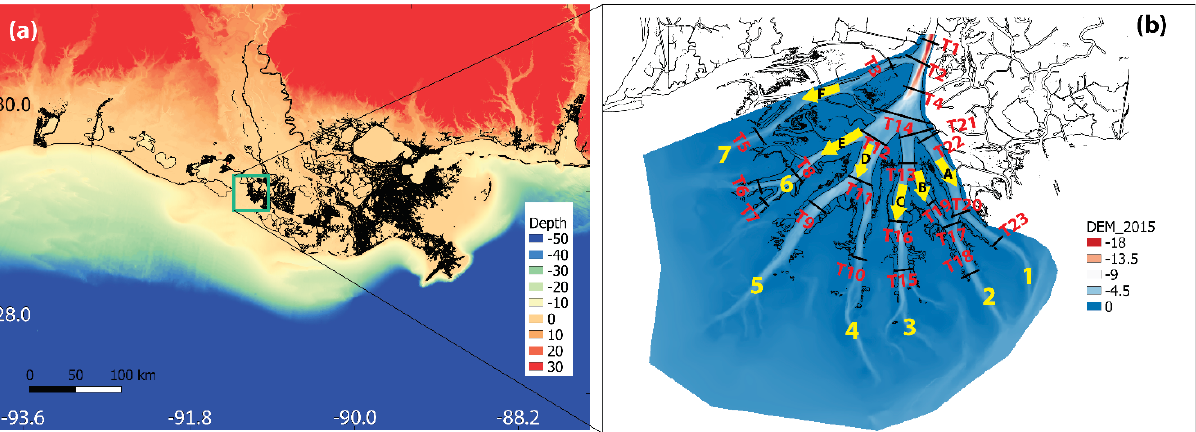
Figure 2. Bathymetry used in the model. ( a ) Depths are given with respect to the reference level (MSL in this study) and negative values are below reference level (MSL). The coordinates are longitude and latitude. The green box indicates the location of the WLD. ( b ) Zoomed in view of the green box of ( a ). The yellow numbers 1 to 7 are used to indicate the seven channels from east to west. The red labels, T1 to T23, indicate cross-sectional transect locations along the delta channels used for model result analysis.